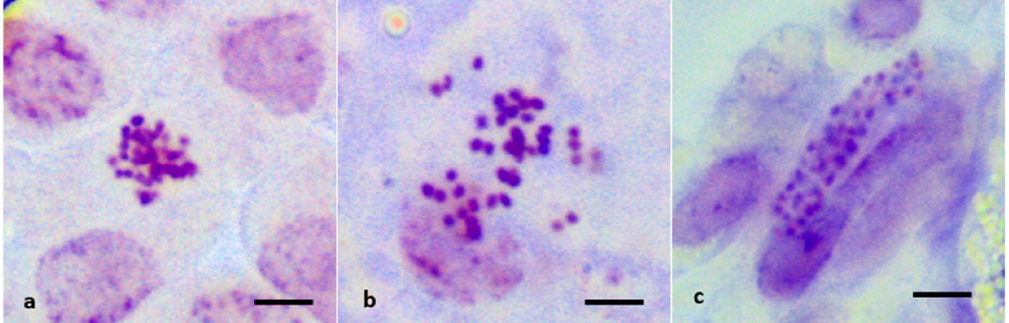
Figure 5. Squashed cells of N. cadamba . (a) inadequately squashed cells - chromosome clumping, (b) unevenly squashed cells - overlapped cells and (c) poorly squashed cells - skidded squash (Bar=5 µm) In this study, ImageJ was used to analyze micrographs obtained during the chromosome count